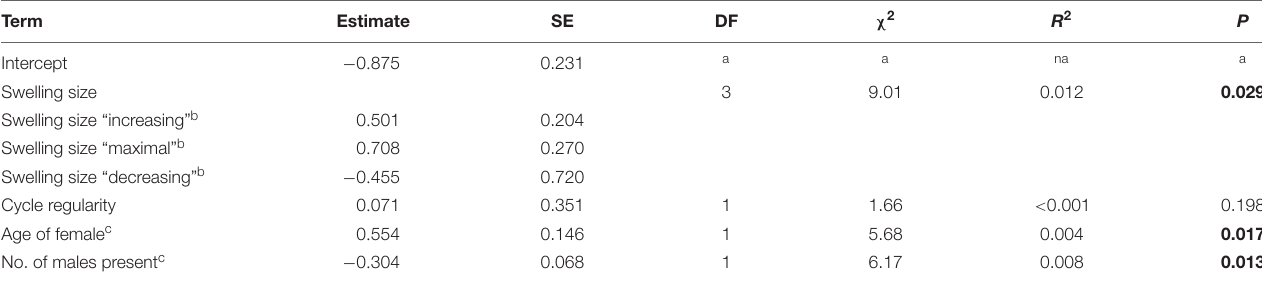
No. of males present c − 0 . 304